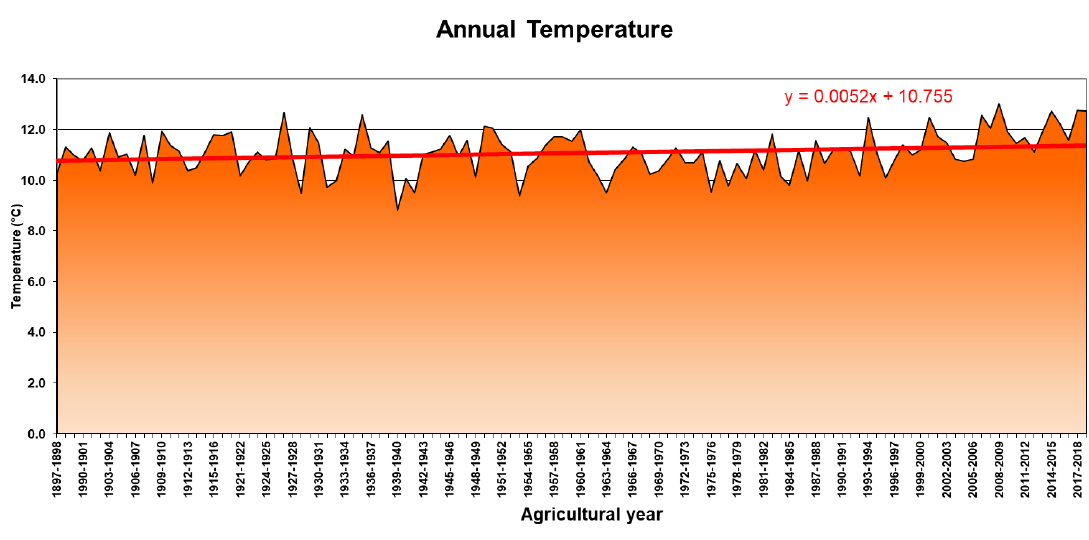
Figure2. EvolutionoftheannualtemperaturerecordedintheBanatPlain, attheRegionalMeteorological Figure 2. Evolution of the annual temperature recorded in the Banat Plain, at the Regional Center Banat-Crisana during the period 1897–2019. Meteorological Center Banat-Crisana during the period 1897 – 2019.